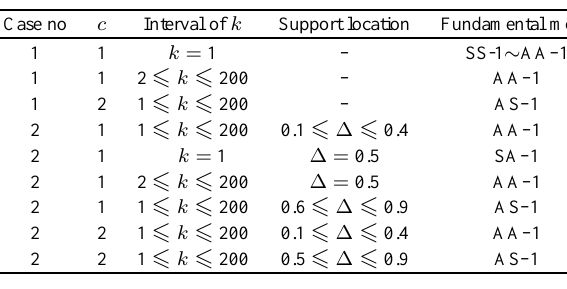
Table 15 Optimum support location (Case